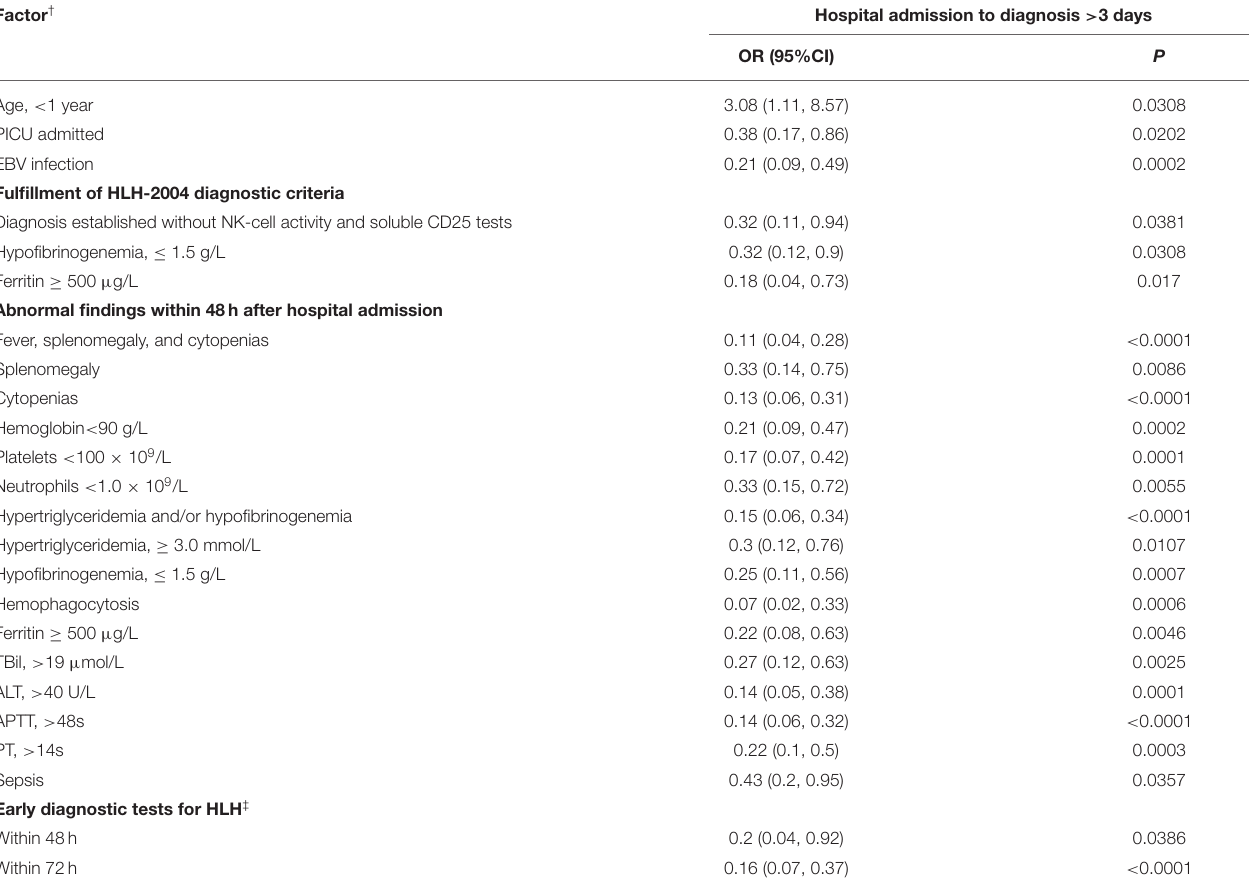
TABLE 4 | Factors associated with a late HLH